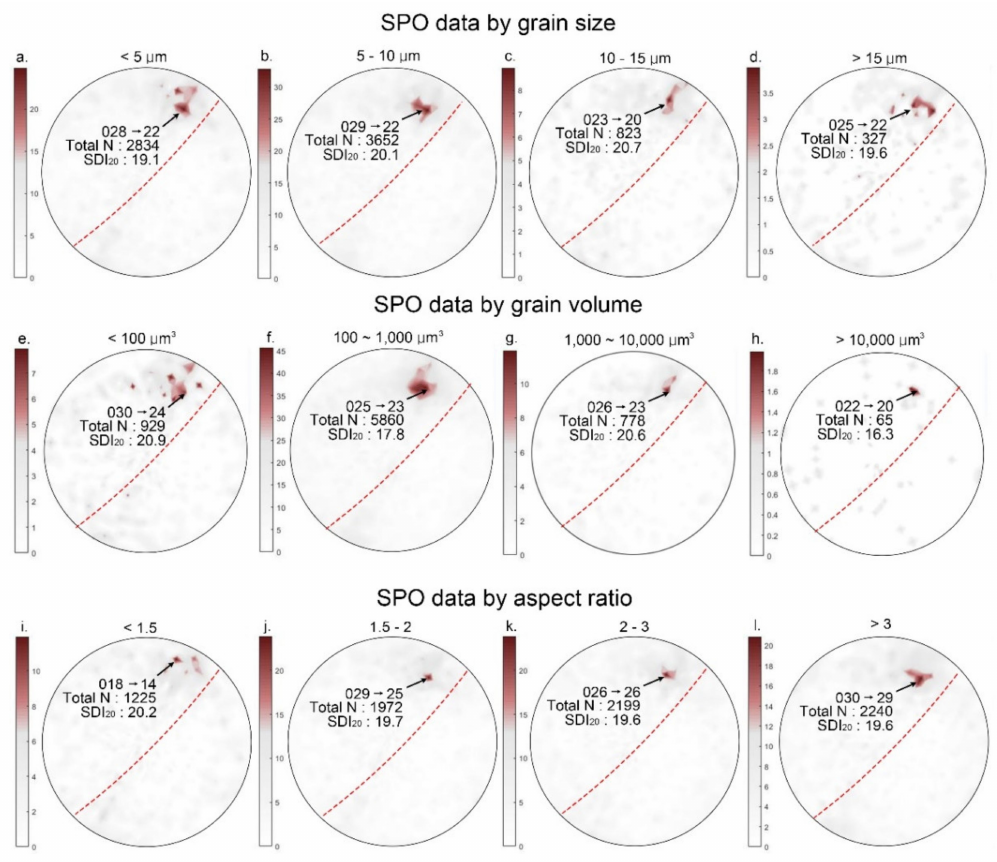
Figure 7. Contour plots showing the results of SPO measurements for the di ff erent size fractions of < 5 µ m ( a ), 5–10 µ m ( b ), 10–15 µ m ( c ), and > 15 µ m ( d ) and for the di ff erent volume of < 100 ( e ), 100–1000 ( f ), 1000–10,000 ( g ), and > 10,000 ( h ) and for the di ff erent aspect ratios of < 1.5 ( i ), 1.5~2 ( j ), 2~3 ( k ), and > 3 ( l ) The red line indicates the fault plane N45 ◦ E 85 ◦